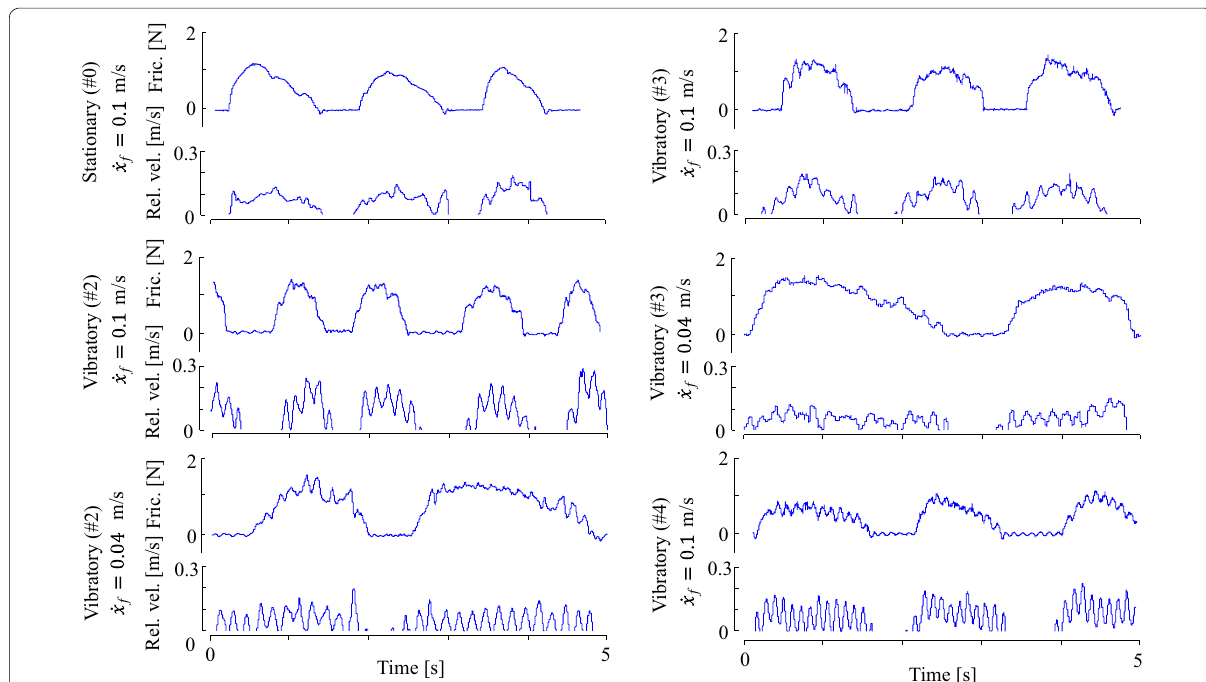
Fig. 12 Examples of friction forces and relative velocities between the finger nail and contactor. Those for stimulus #2 are from Fig. 11 for